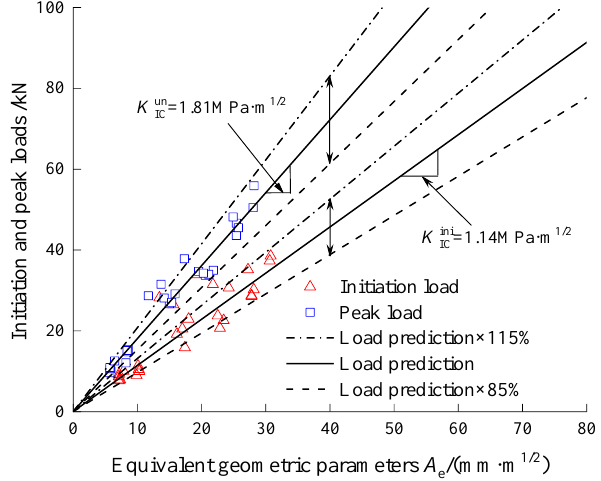
Figure 7. Predicted results of initiation and peak loads.